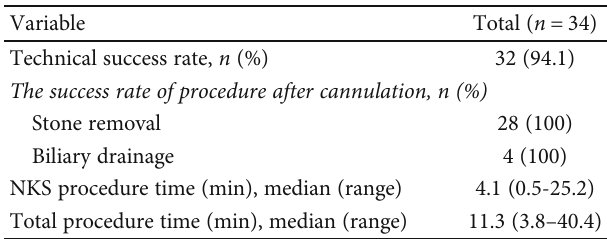
Table 2: Clinical outcomes of primary NKS.